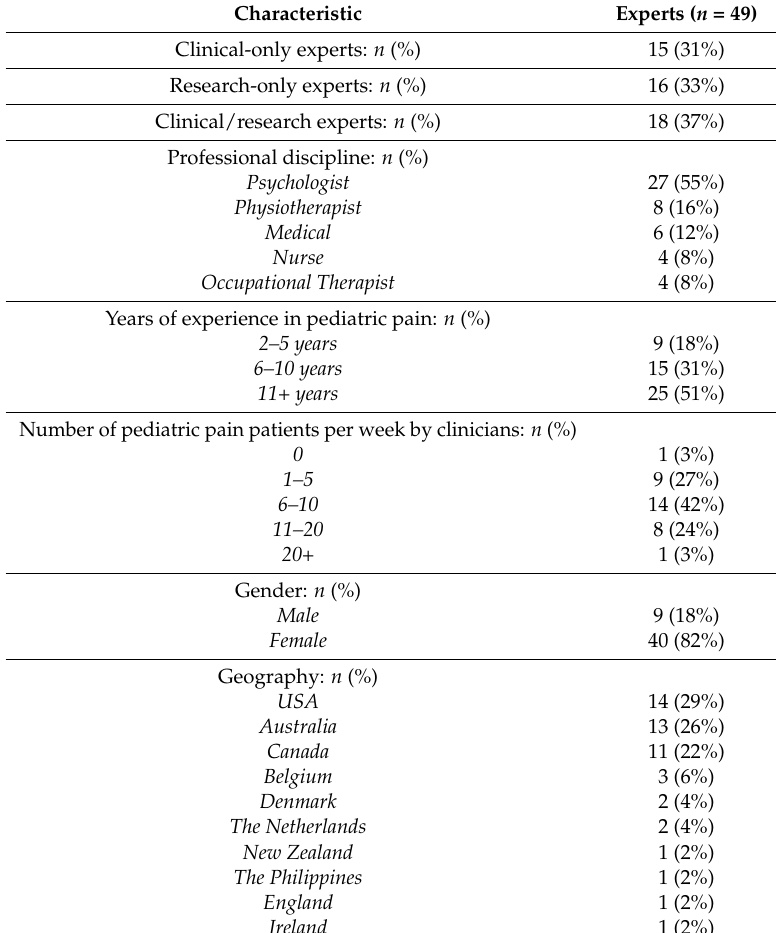
Table 1. Demographics of the pediatric pain experts who participated in the